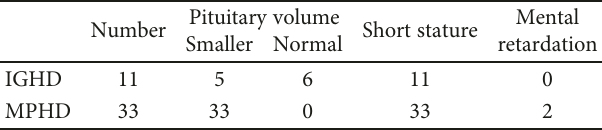
Table 4: Relationship of abnormal hormone secretion in the anterior pituitary with pituitary volume and patient